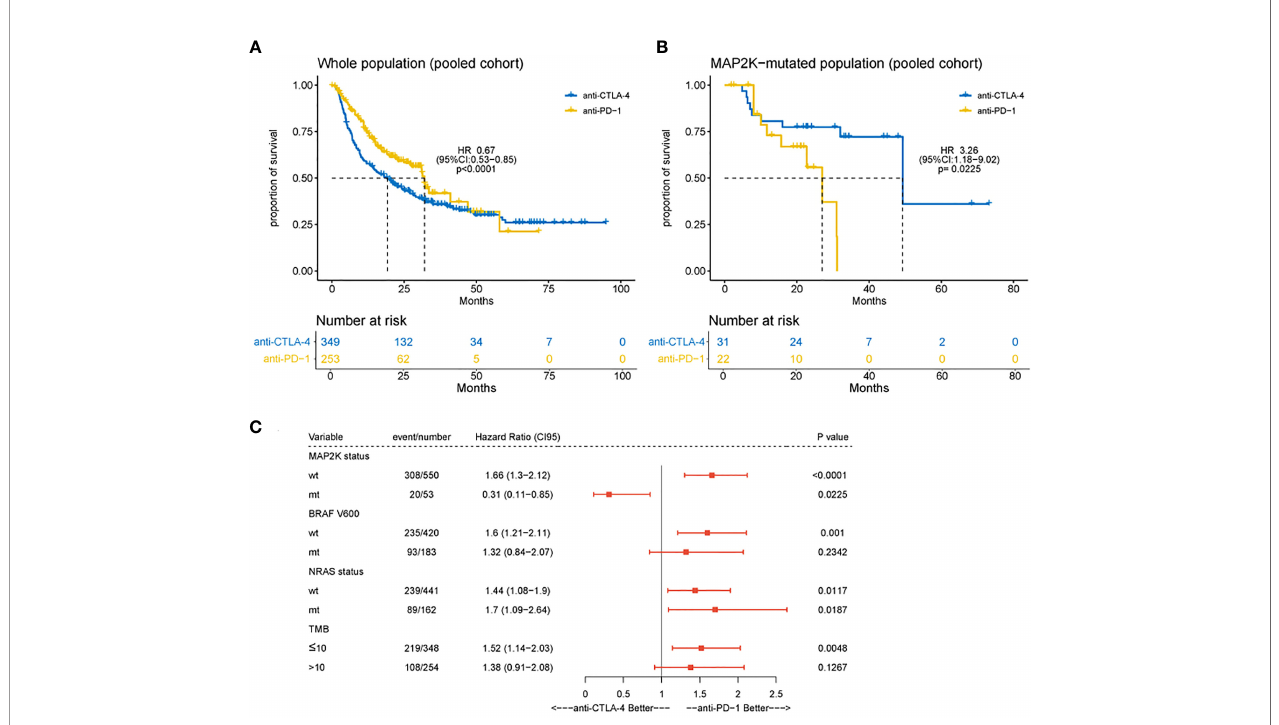
FIGURE 3 | Difference in overall survival between melanoma patients receiving anti-CTLA-4 or anti-PD-1 monotherapy. Kaplan-Meier analyses of overall survival (OS) in overall population (A) and MAP2K1/2 -mutated subgroup (B) in the combined cohort of anti-CTLA-4 and anti-PD-1-treated patients. Subgroup Cox analysis of OS among patients receiving anti-CTLA-4 or anti-PD-1 monotherapy (C)